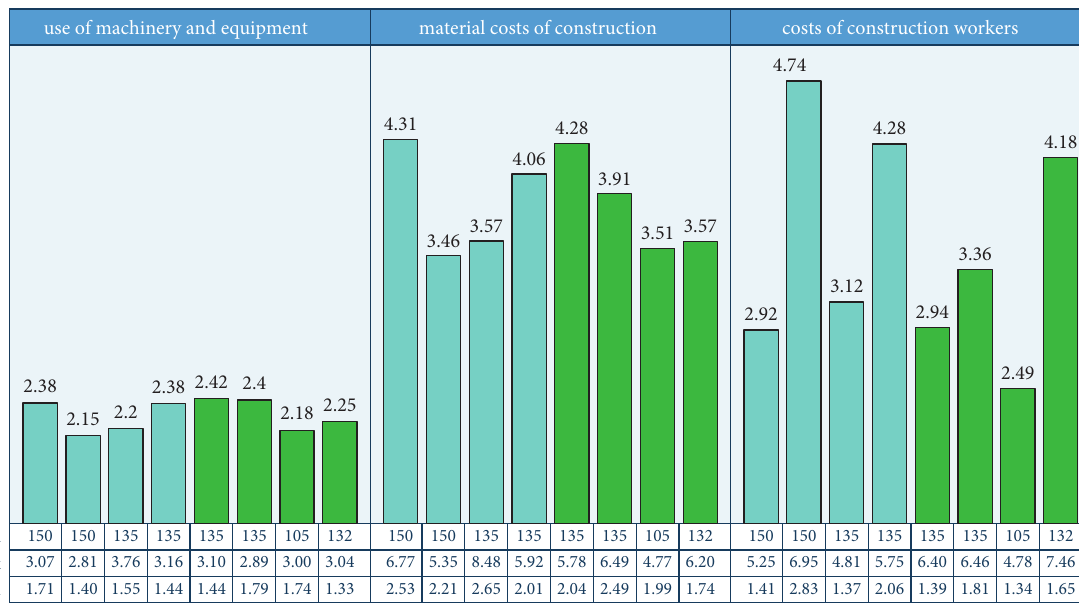
Figure 4: Direct cost distribution of virtual network mapping collection based on the optimal